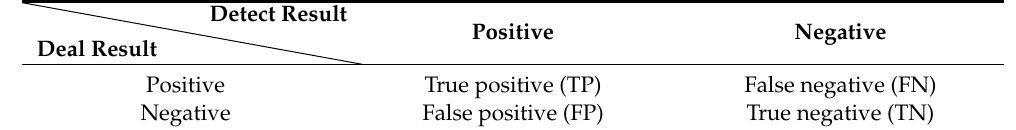
Table 3. Confusion matrix.